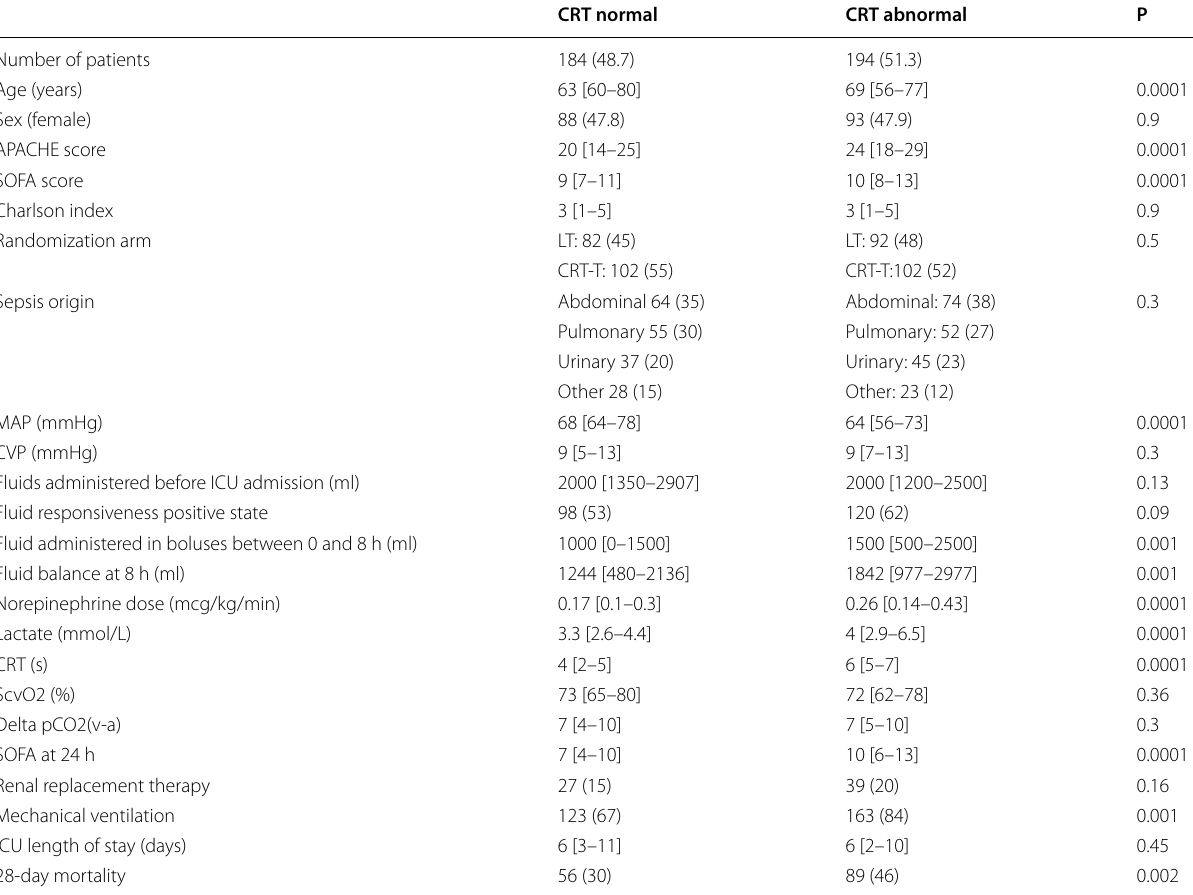
Table 1 Baseline characteristics and clinical outcomes of septic shock patients with normal versus abnormal capillary refill time at 2 h from inclusion